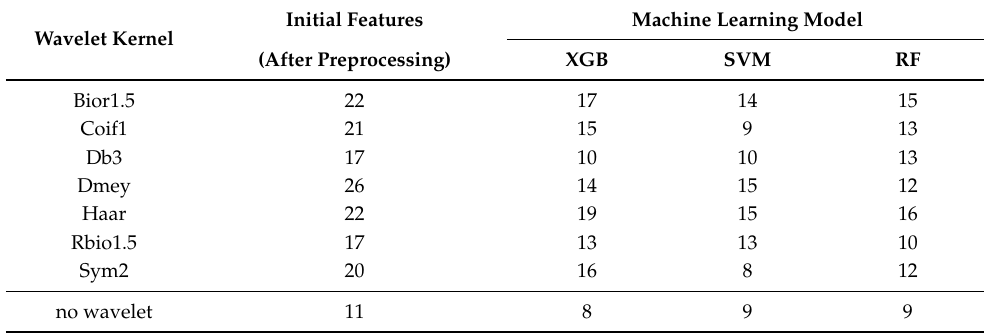
Table 3. Features selected using the SFS, for each wavelet kernel with the ML models considered. Wavelet